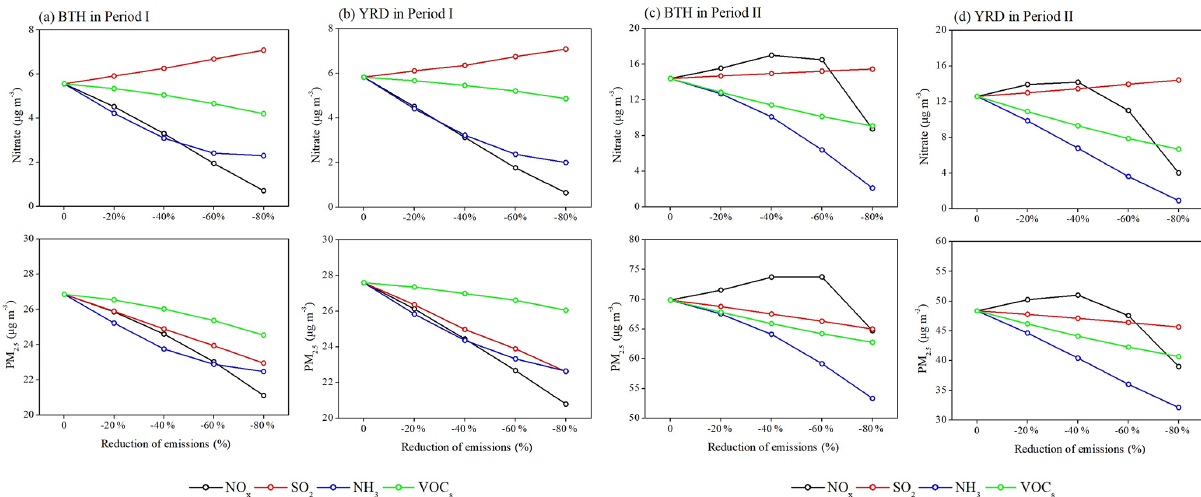
Figure 12. Responses of the surface nitrate (upper panels) and PM 2 . 5 (bottom panels) concentrations to the emission reduction scenarios of NO x , SO 2 , NH 3 and VOCs during Period I (a,b) and Period II (c,d)